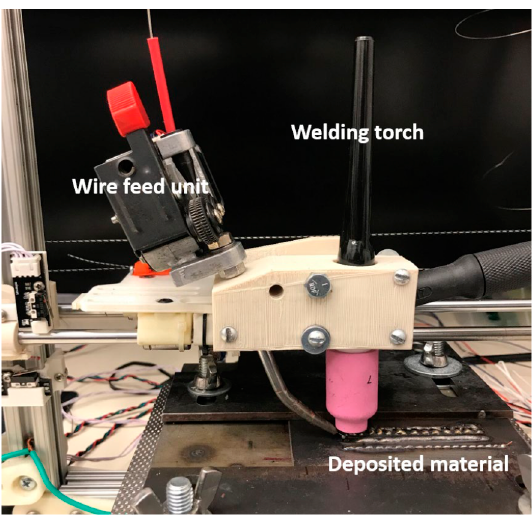
Figure 11. Modified WAAM system, including new 3D printed fixtures and holders.